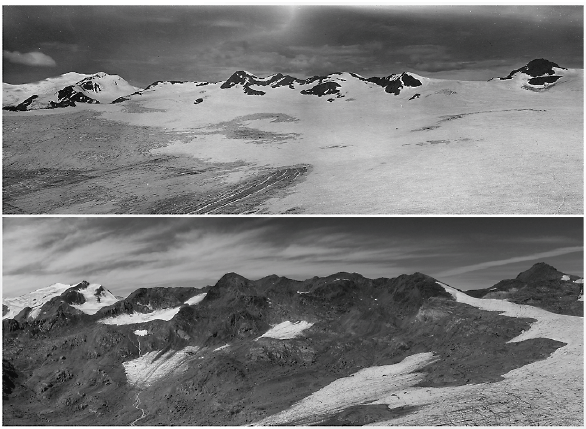
Fig. 5. Photographic comparison of the Careser Glacier in August 1933 (above, courtesy of Comitato Glaciologico Italiano) and on 28 August 2012 (below, photo L. Carturan).